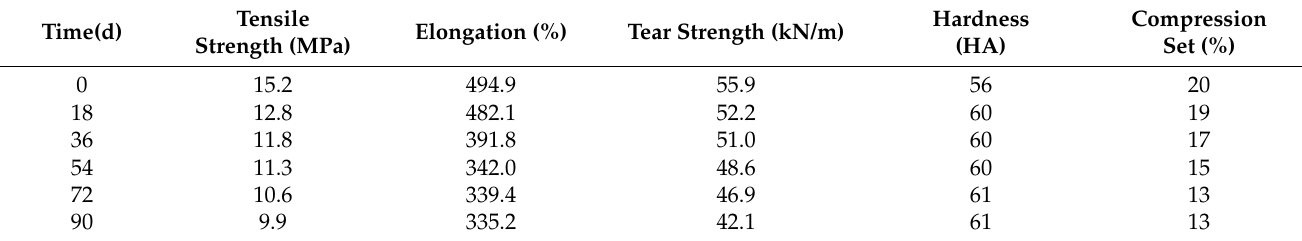
Table 2. Mechanical properties of aging rubber waterstop in low-temperature water environment.